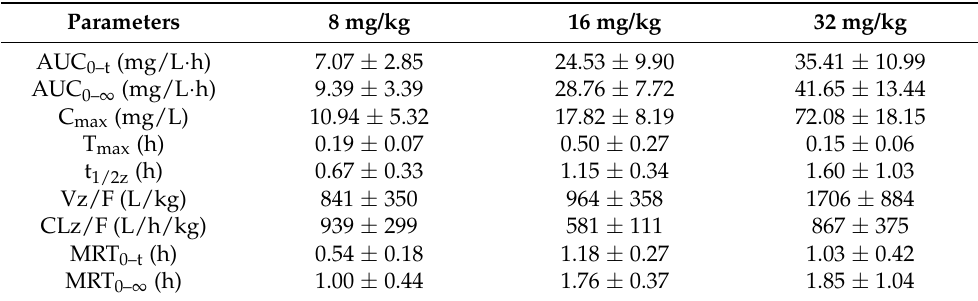
Figure 4. Plasma concentration–time curves of physalin A after a single dose of physalin A at 8, 16 and 32 mg/kg to rats (mean ± SD, n = 6). Table 3. Pharmacokinetic parameters of physalin A in rats after a single oral administration of physalin A at 8, 16 and 32 mg/kg.